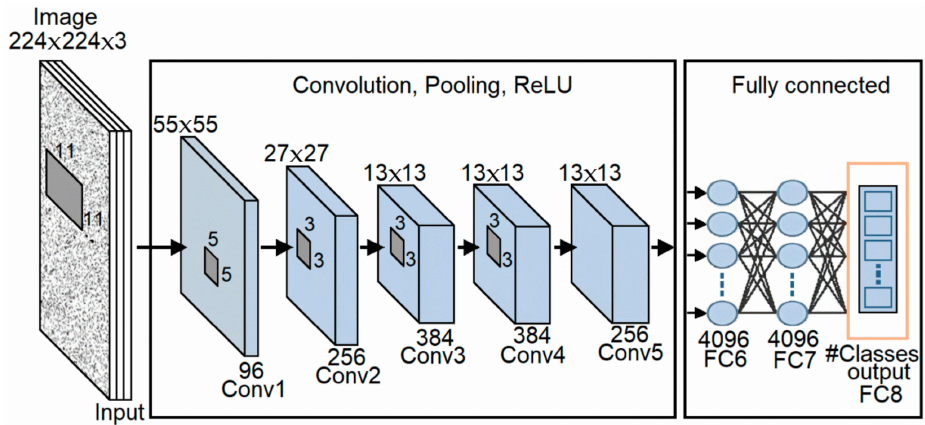
Figure 2. Details of the trained CNN model used in this research. The layer FC8 is marked to indicate the resizing of this layer according to the number of classes in the new